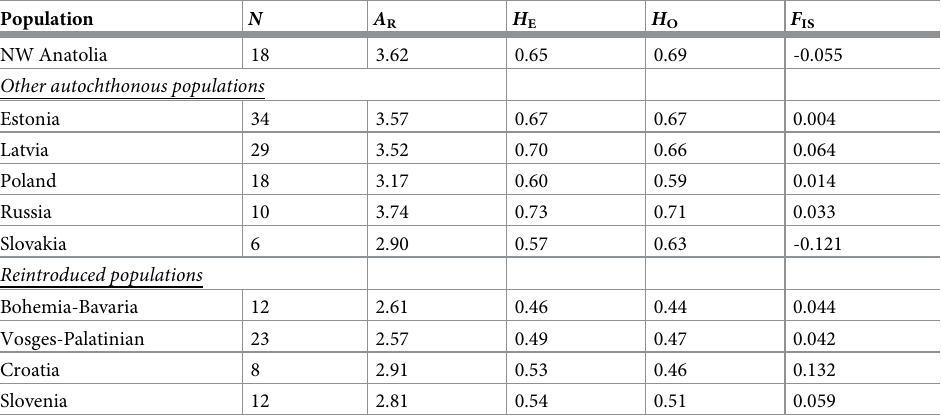
Table 3. Comparison between the northwestern Anatolian lynx population and other autochthonous and reintro- duced European lynx populations [14], based on reanalysis of 10 shared microsatellite loci.